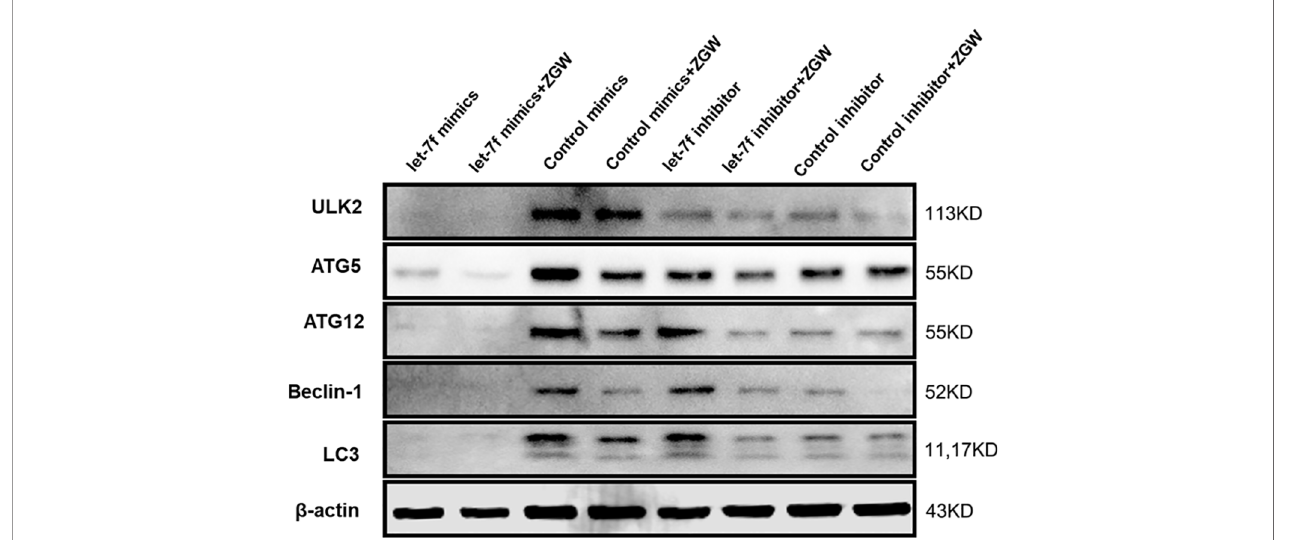
FIGURE 9 | Changes in autophagy-related protein expressions (ULK2, ATG12, ATG5, Beclin-1, and LC3).